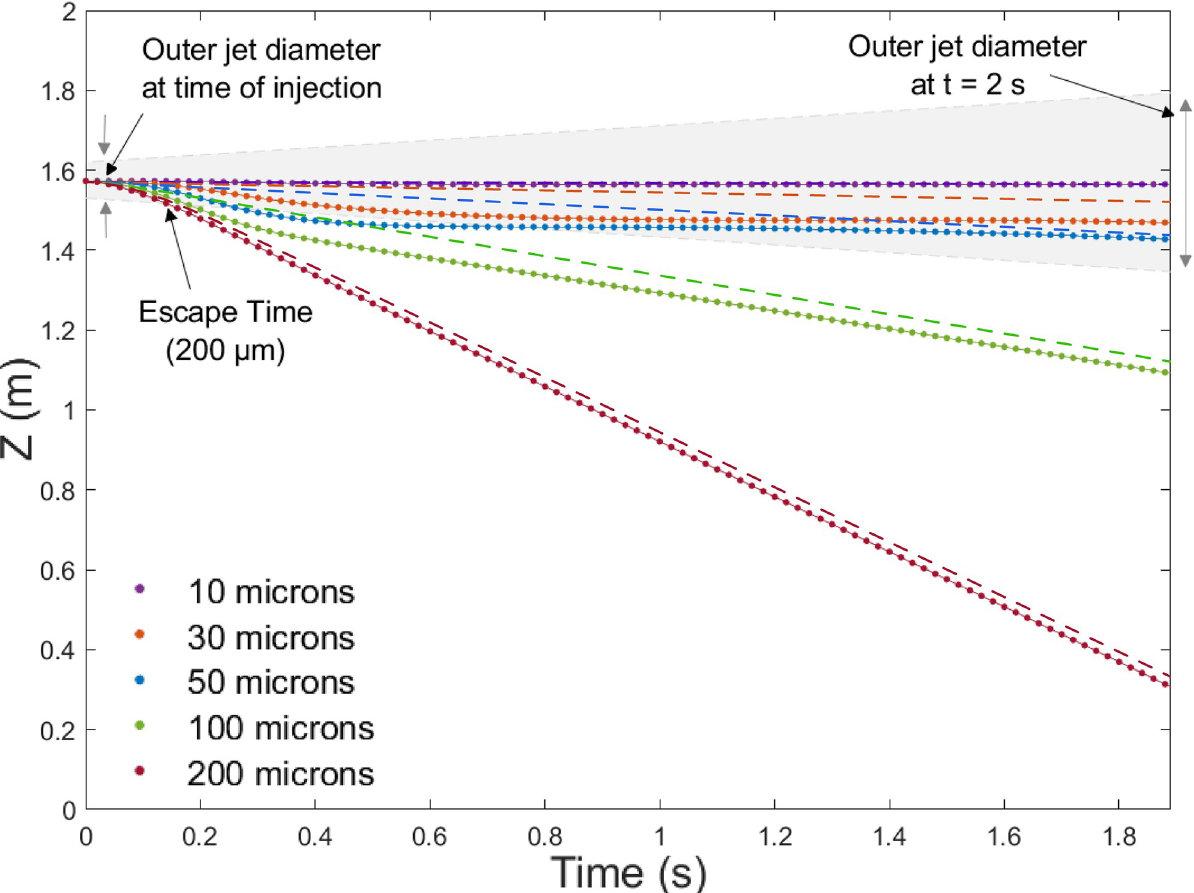
Fig 2. Particle trajectories. Mean vertical travel distance of particles of different sizes over a 2 s interval after injection in a 10 m/s jet. Dashed lines indicate the predicted particle trajectories based on a simple drag